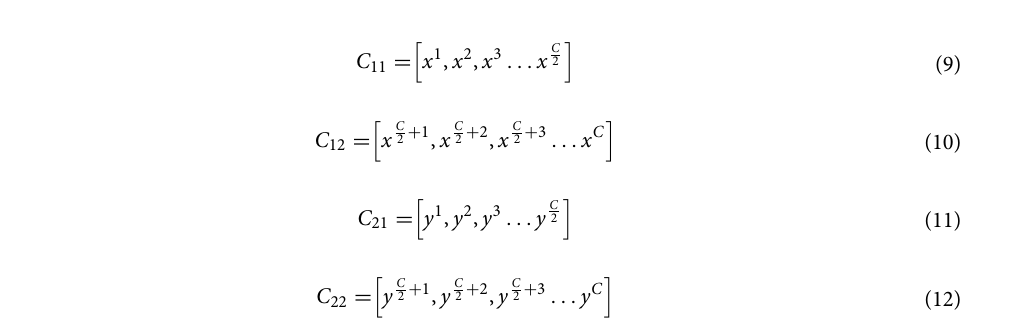
Figure 3. Shared channel residual